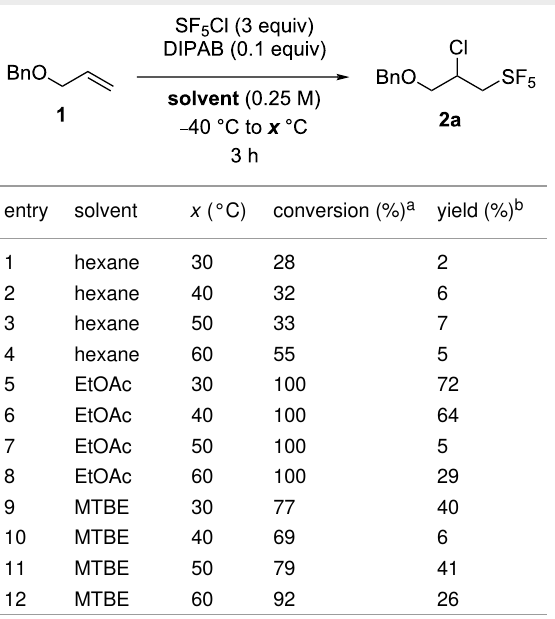
Table 1: Selected optimization results for the SF 5 Cl addition on allyl benzyl ether ( 1 ) using DIPAB as the radical initiator.